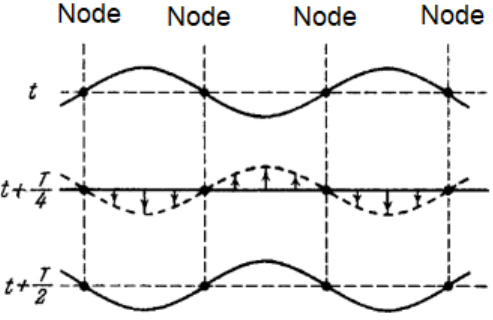
Figure 2. The presentation of modes.